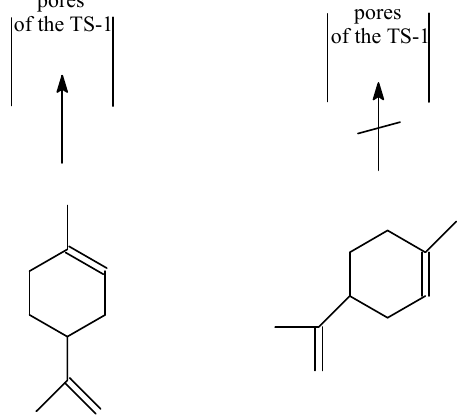
Figure 1. The possible mode of entry of the limonene molecules into the narrow pores of the TS-1